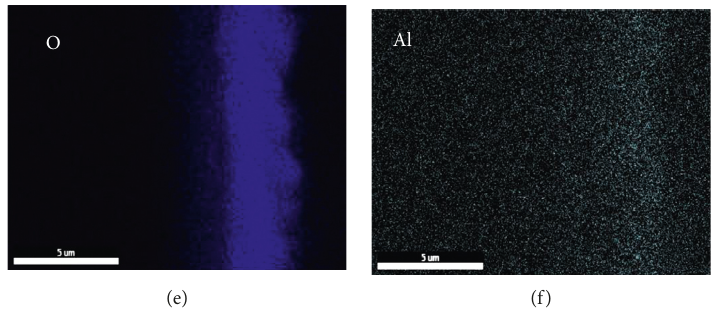
Figure 21: Elemental maps of the cross section of the B-123 (YSZ) sample.